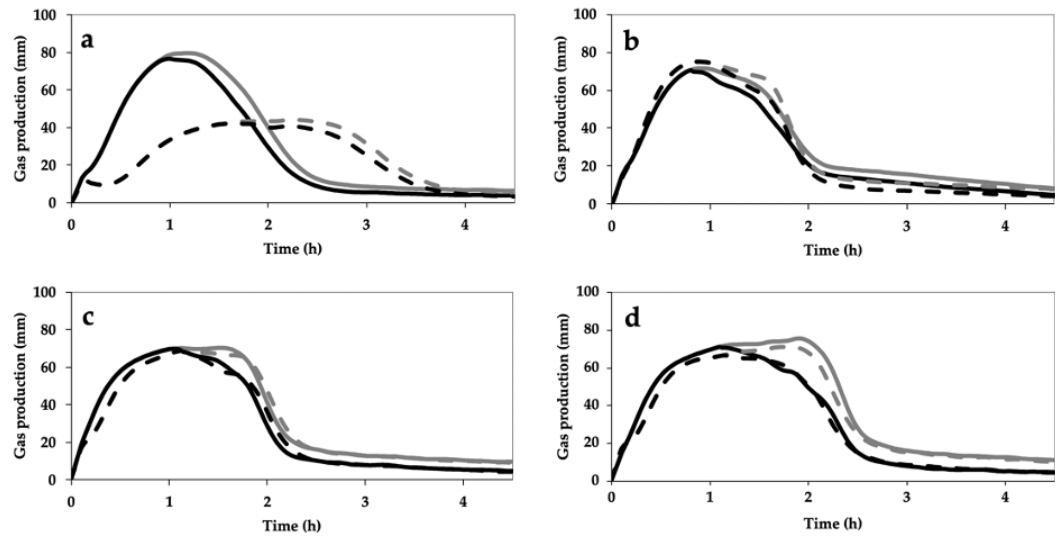
Figure 5. Effect of stone milling (solid line) and roller milling (dash line) on the total gas production (grey line) and on the retained gas (black line) in the dough, assessed by Rheofermentometer ® , of whole grain flours from Bolero cv ( a ), CWRS ( b ), Bona Vita cv ( c ) and Skorpion cv ( d ).